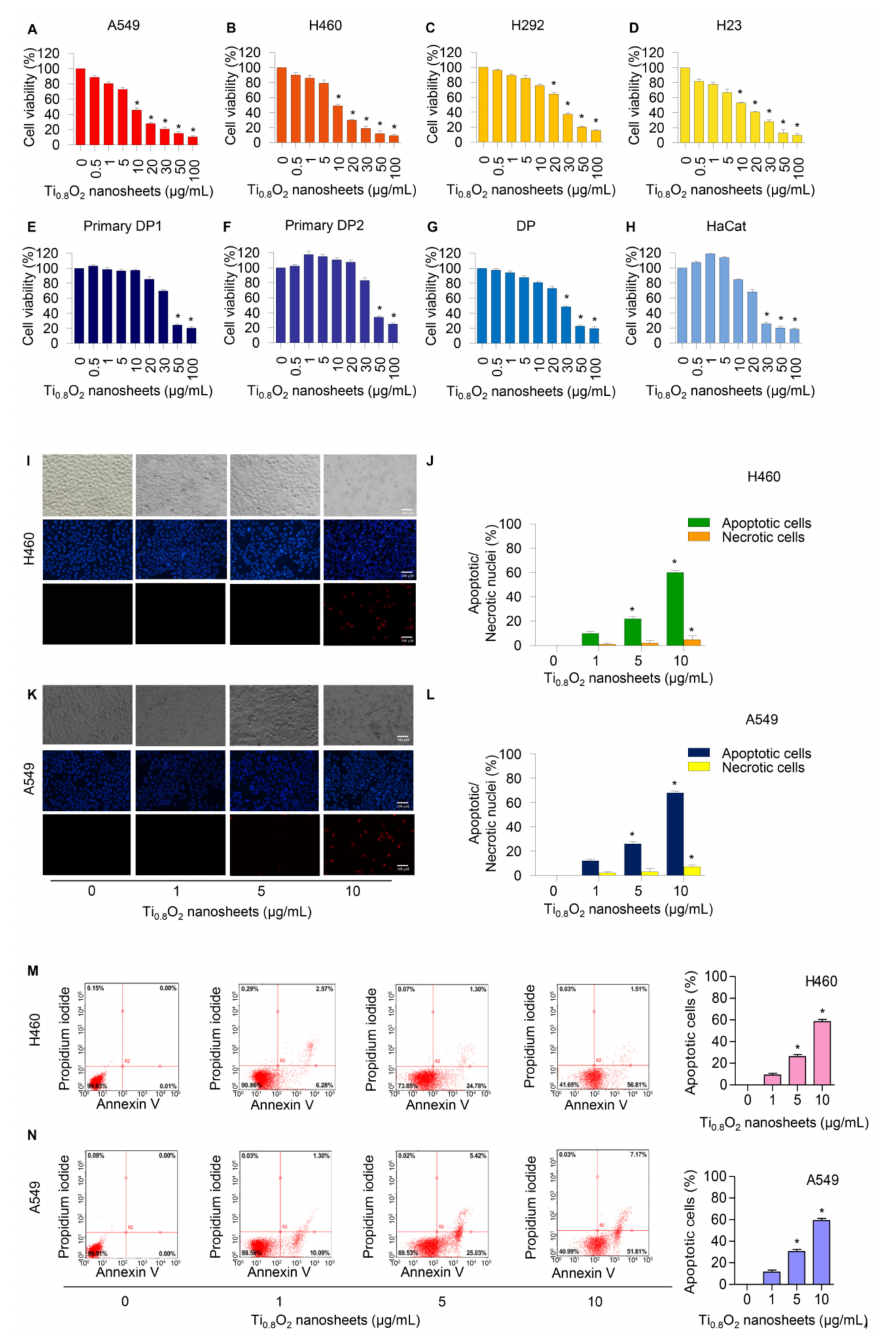
Figure 2. Cytotoxicity of Ti 0.8 O 2 nanosheets on human lung cancer cells and normal cells. Ti 0.8 O 2 nanosheets reduced cell viability and induced apoptosis in lung cancer cells. ( A – H ) Effect of Ti 0.8 O 2 nanosheets on cell viability of lung cancer cells (A549, H460, H292, and H23 cells) and normal cells (dermal papilla (DP), primary DP1, primary DP2, and HaCaT keratinocyte cells) for 24 h using MTT assays; ( I – L ) morphology of apoptotic nuclei stained with Hoechst 33342 dye and propidium iodide in cells treated with Ti 0.8 O 2 nanosheets, determined by visualization using fluorescence microscopy and calculated percentages of nuclear fragmented and PI-positive cells; ( M , N ) apoptotic and necrotic cells were determined using annexin V-FITC/PI staining with flow cytometry; data are shown as the mean ± SEM ( n = 3). * p < 0.05 versus non-treated